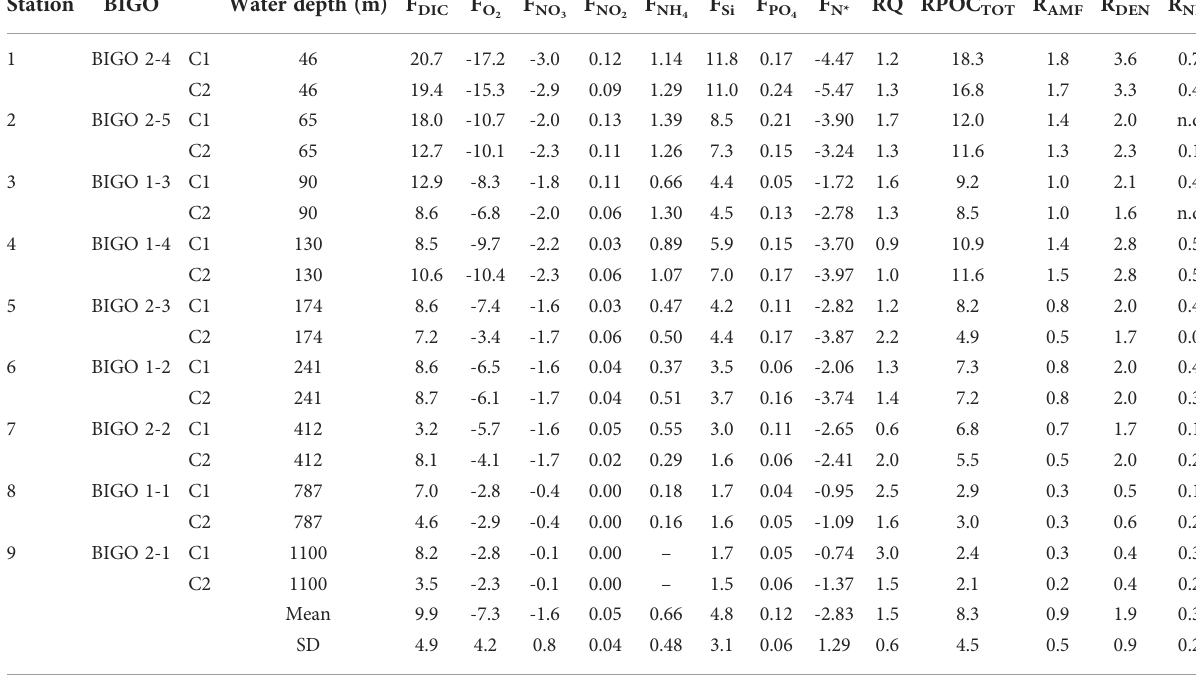
TABLE 2 Benthic fl uxes (F) measured in the individual benthic chambers (mmol m – 2 d – 1 ) across the transect, the respiratory quotient (RQ, see text) and depth-integrated reaction rates, R [Eq. (2)-(5)]. Station